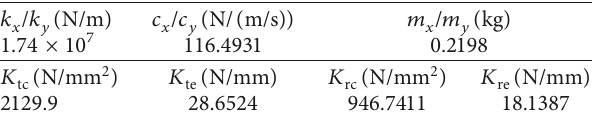
Figure 13: Setup of cutting experiments and impact Table 3: Modal parameters of cutter and cutting force coefficients.